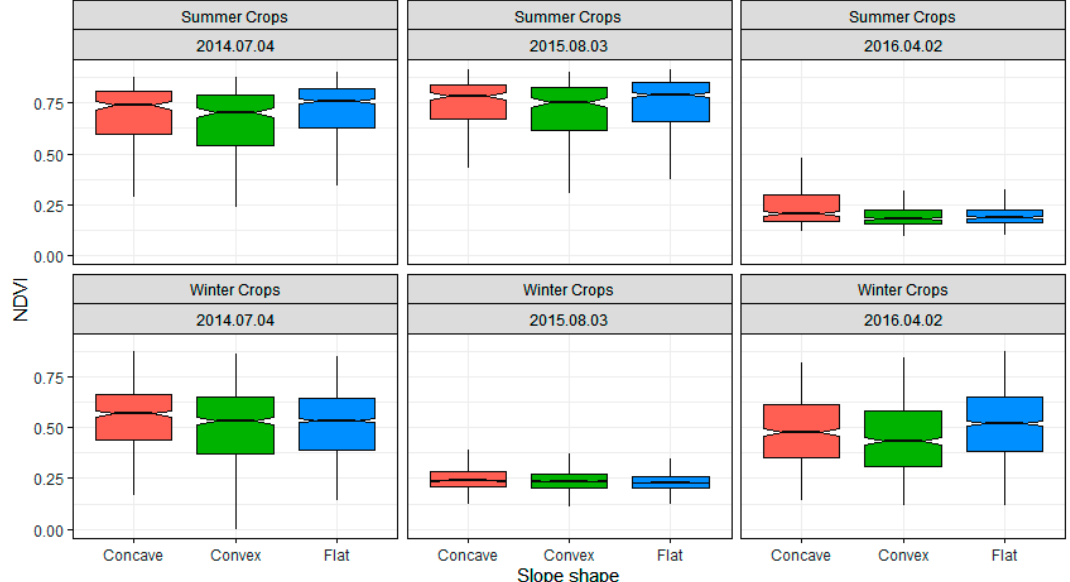
Figure 9. Box plots indicating influences of slope shapes on NDVI values across crop categories and seasons. Winter Crops are composed of WW, WB, WR, and Wry, while Summer Crops are Mz, SB, and SC. Notches indicate significant impact between slope shape categories on median NDVI values (the scene dates are chosen based on statistically significant impact on C ndvi estimates according to Table 5).